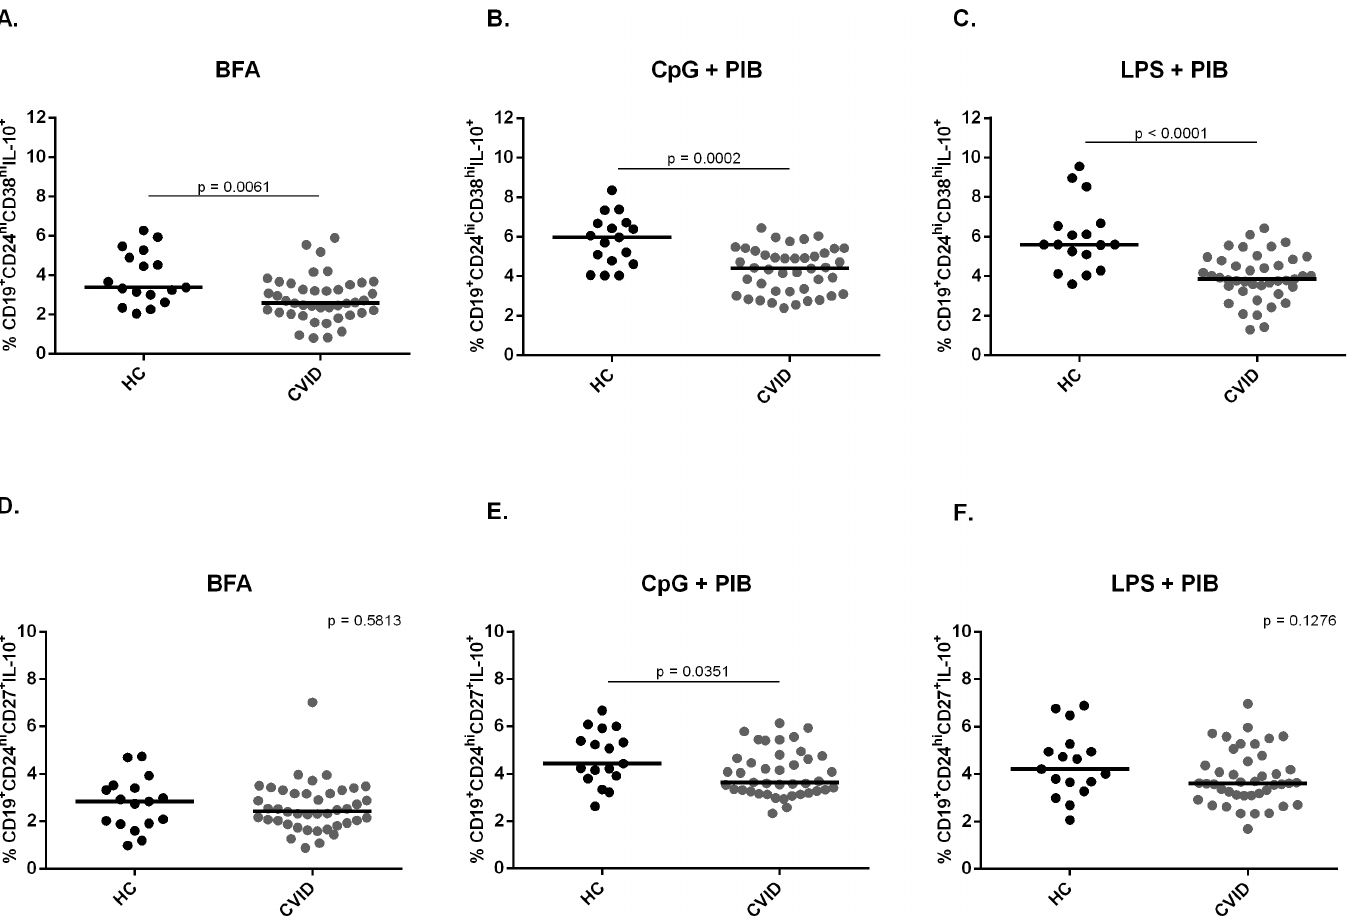
Fig 2. Frequency of CD24 hi CD38 hi and CD24 hi CD27 + B10 cells in healthy controls and CVID patients. The expression of intracellular IL-10 and surface markers CD24, CD38 and CD27 were determined by flow cytometry after in vitro stimulation of PBMC for 5h with only BFA; CpG + PIB or LPS + PIB. Scatter plots show the percentages of B10 cell subsets (A,B,C) CD19 + CD24 hi CD38 hi IL-10 + and (D,E,F) CD19 + CD24 hi CD27 + IL-10 + in peripheral blood of 17 healthy controls (HC) and 42 CVID patients. Bars represent the mean value. P values were calculated by Mann-Whitney test.